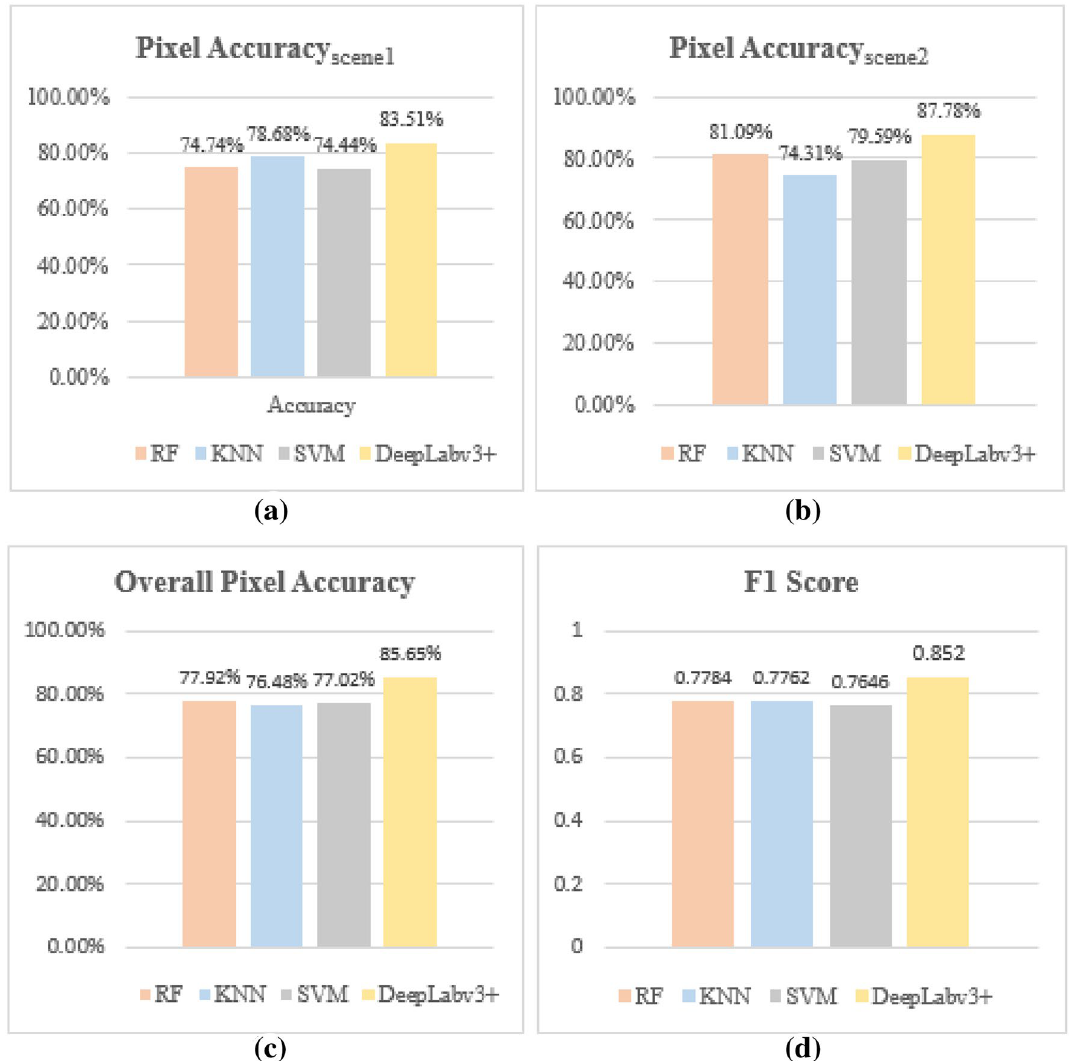
Figure 3. Represents the performance measures. ( a ) and ( b ) represents the pixel accuracy for scene 1 and scene 2 respectively; ( c ) represents overall pixel accuracy for both scenes/patches; ( d ) represents F1 score for both scenes/patches for RF, KNN, SVM, and DeepLabv3+